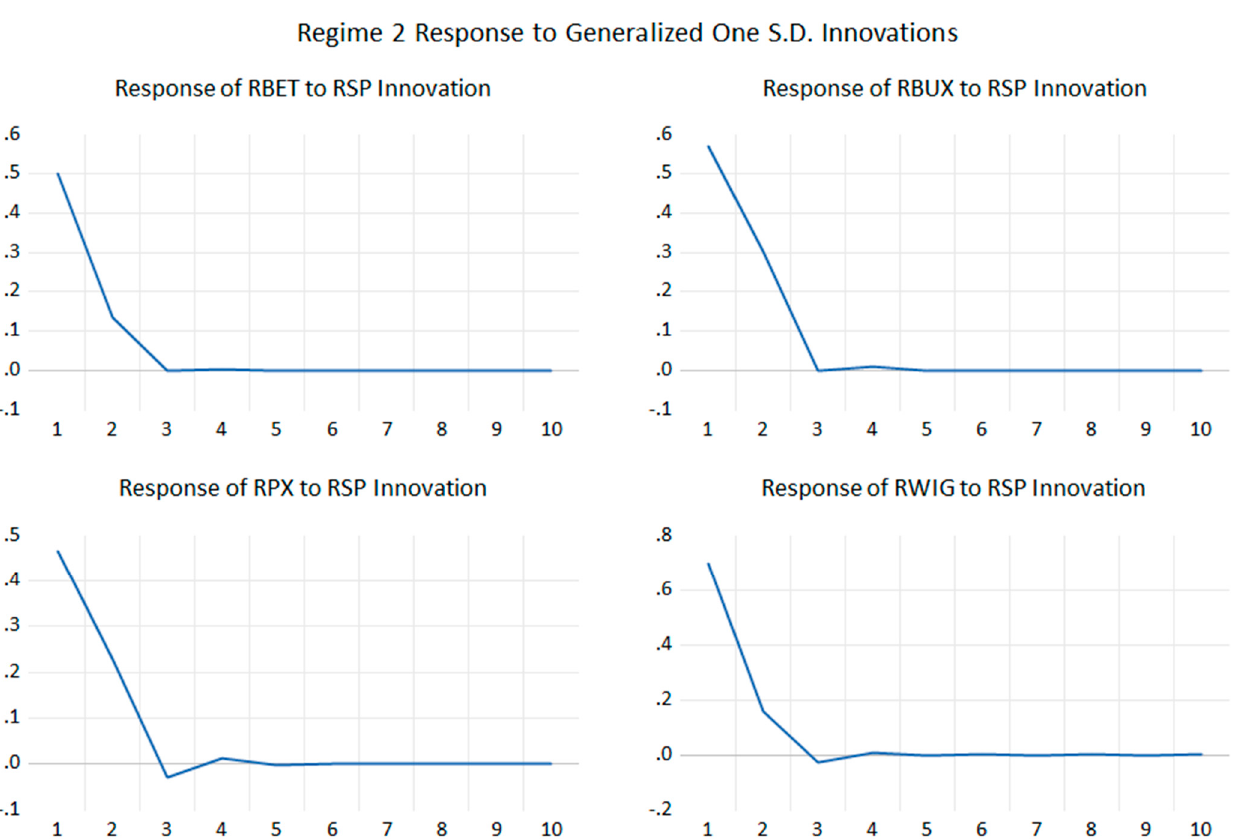
Figure A9. Impulse Responses of CEE Stock Markets to a Shock in the US Stock Markets in Both Regimes.